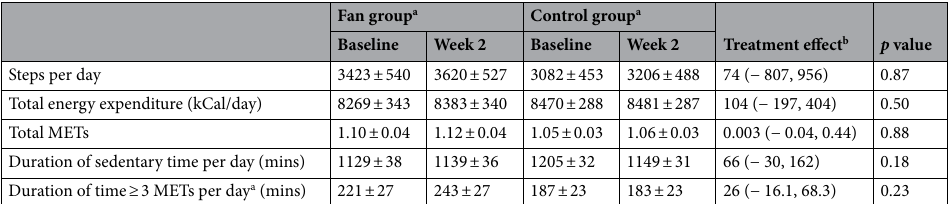
Table 4. Physical activity levels measured using SenseWear armbands between baseline and Week 2. Data are expressed as a mean ± standard error or b mean difference (95% confidence interval). p values are between group comparison. METs metabolic equivalents of